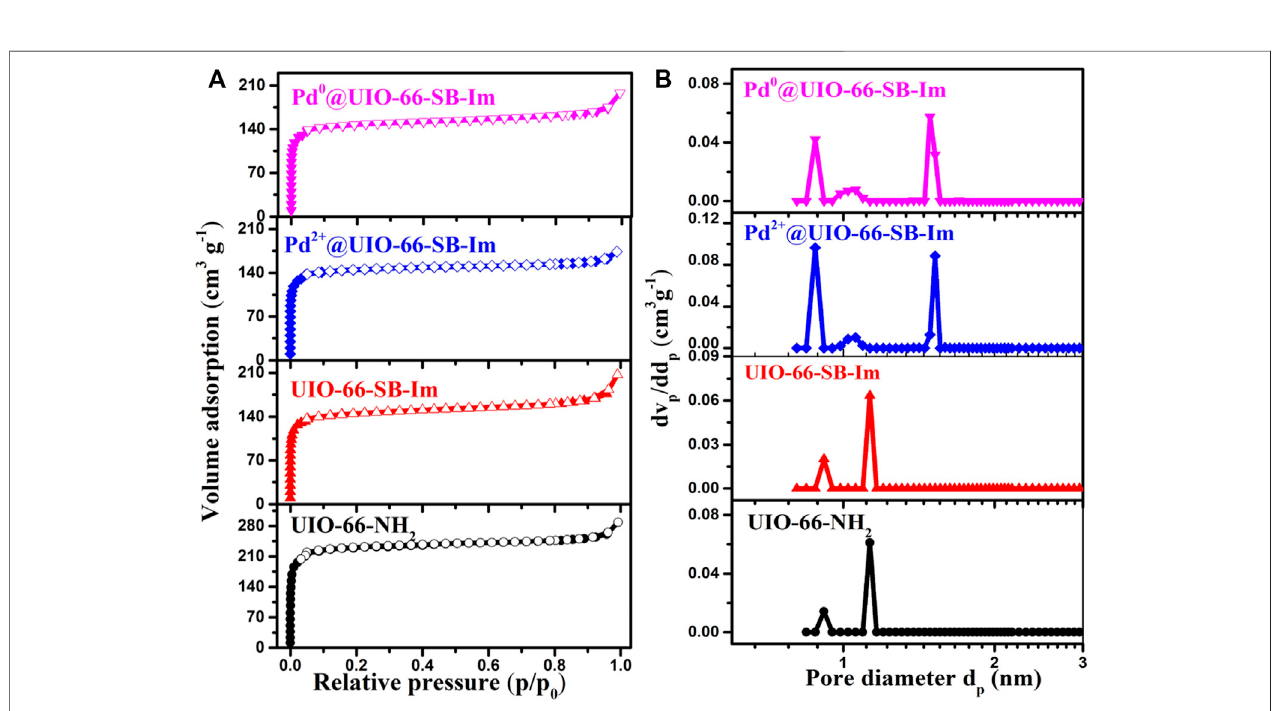
FIGURE 3 | (A) Nitrogen (N 2 ) adsorption – desorption isotherms and (B) pore size distribution curves of different samples.